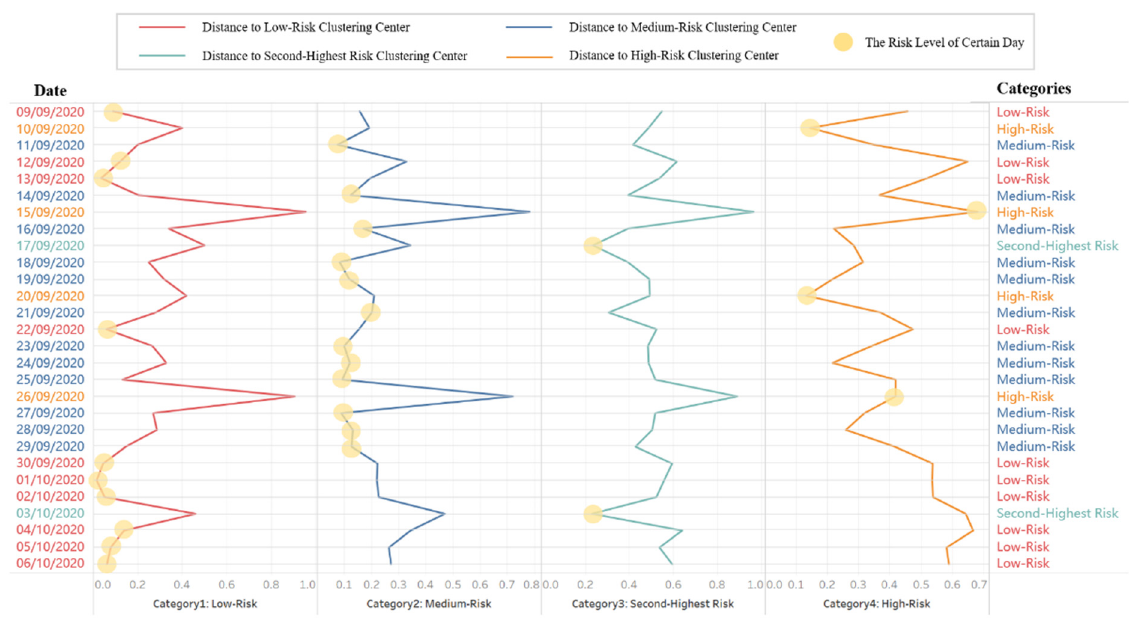
Figure 11. Threshold of risk classification determined by the distance to the clustering center.